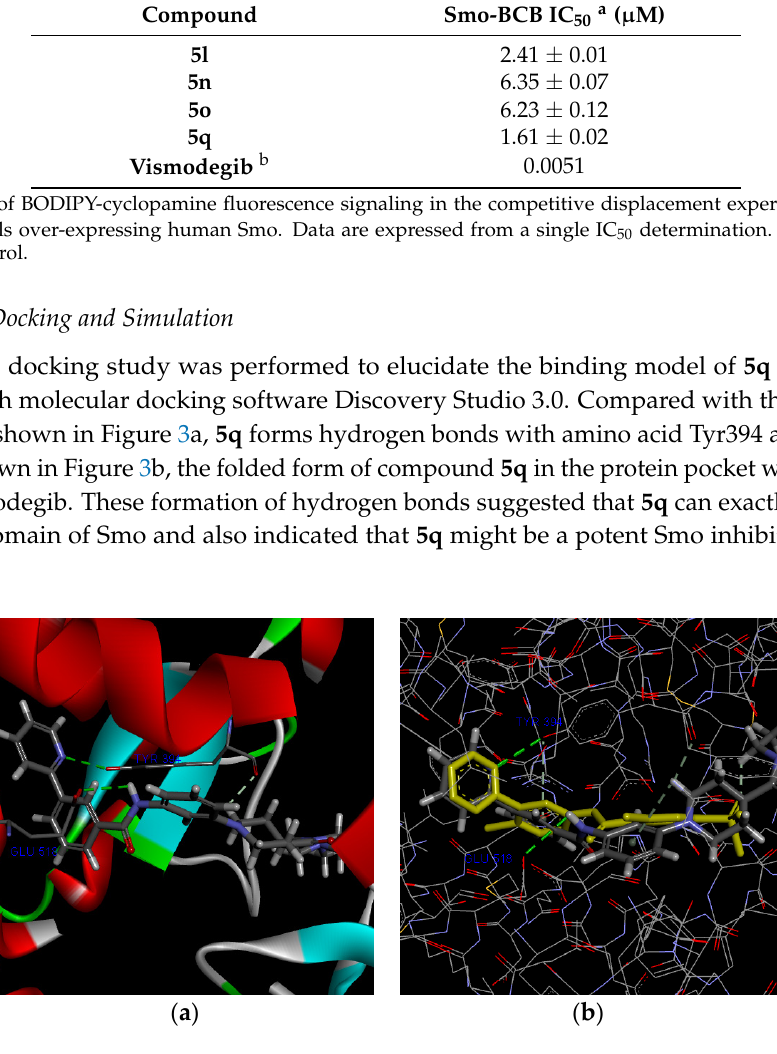
Figure 3. ( a ) Key interactions of 5q in the active site of Smo. ( b ) The binding pose of 5q and Vismodegib in the active site of Smo. Vismodegib was highlighted with yellow. Atoms are color ‐ coded: Grey, carbon; white, hydrogen; red, oxygen; purple, nitrogen, bonds are color ‐ coded: Green, classical hydrogen bonds; white, non ‐ classical hydrogen